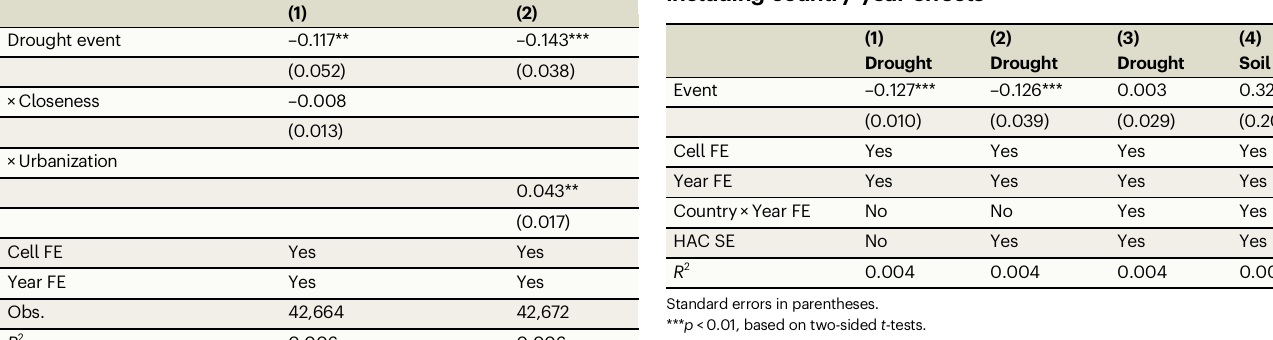
Table 4 | Effects of drought events (columns 1 – 3) and soil degradation (column 4) on population: speci fi